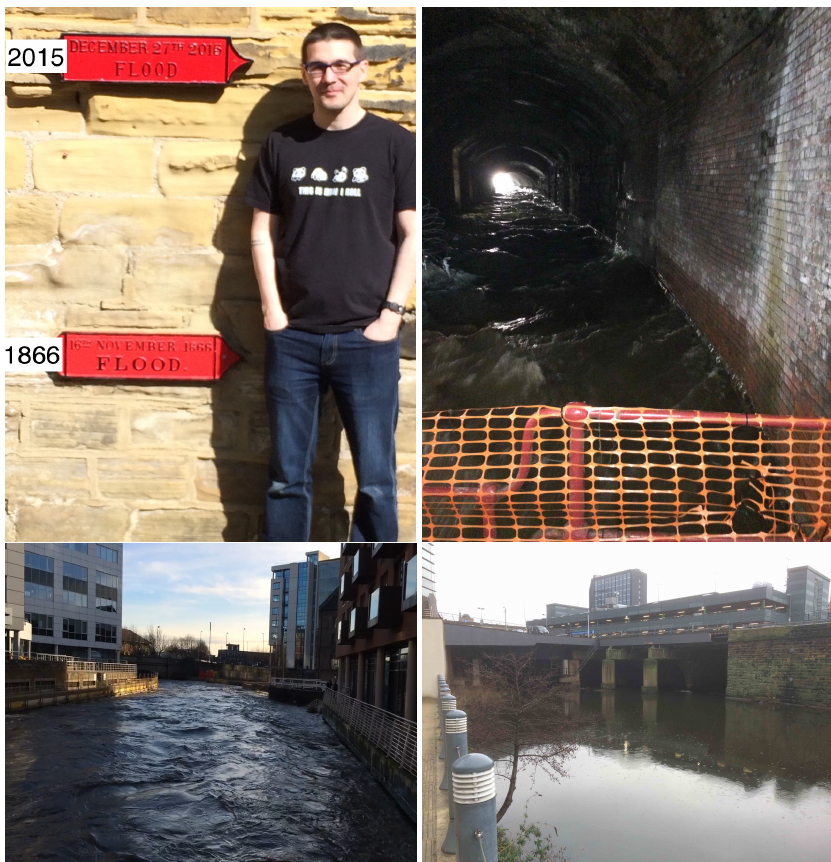
Figure 3. Top left : plaques at Leeds’ Armley Mills Museum indicate 1866 and 2015 flood-peak levels, the latter associated with the peak level of 5.22 m at the Armley river-level gauge. Craig Duguid (Fluid Dynamics’ Centre for Doctoral Training, Leeds) provides a sense of scale. Top right : high level and supercritical flow in the “Dark Arches” underneath Leeds railway station at 13:36:04 on 27 December 2015; the high-water mark on the wall outlines the peak level, at 13:36:36 on 27 December 2015. Bottom left : subcritical flow emanating from these arches at 13:29:42 on 27 December 2015. Bottom right : entrance and top of the weir at these arches on 19 February 2018 with subcritical inflow. Photos and video-grabs courtesy of